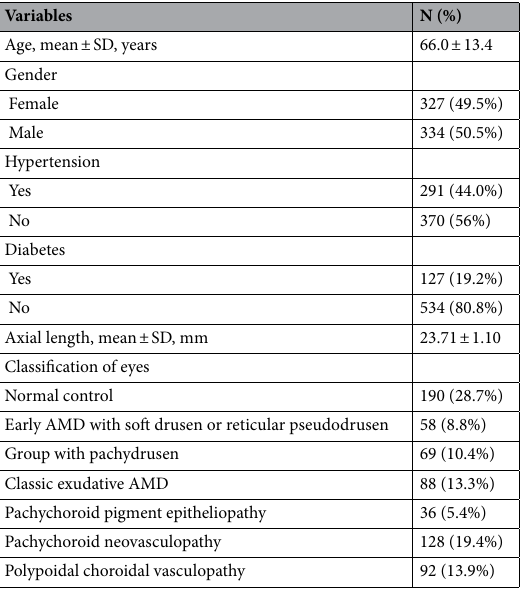
Table 1. General characteristics of included patients. SD, standard deviation; AMD, age-related macular